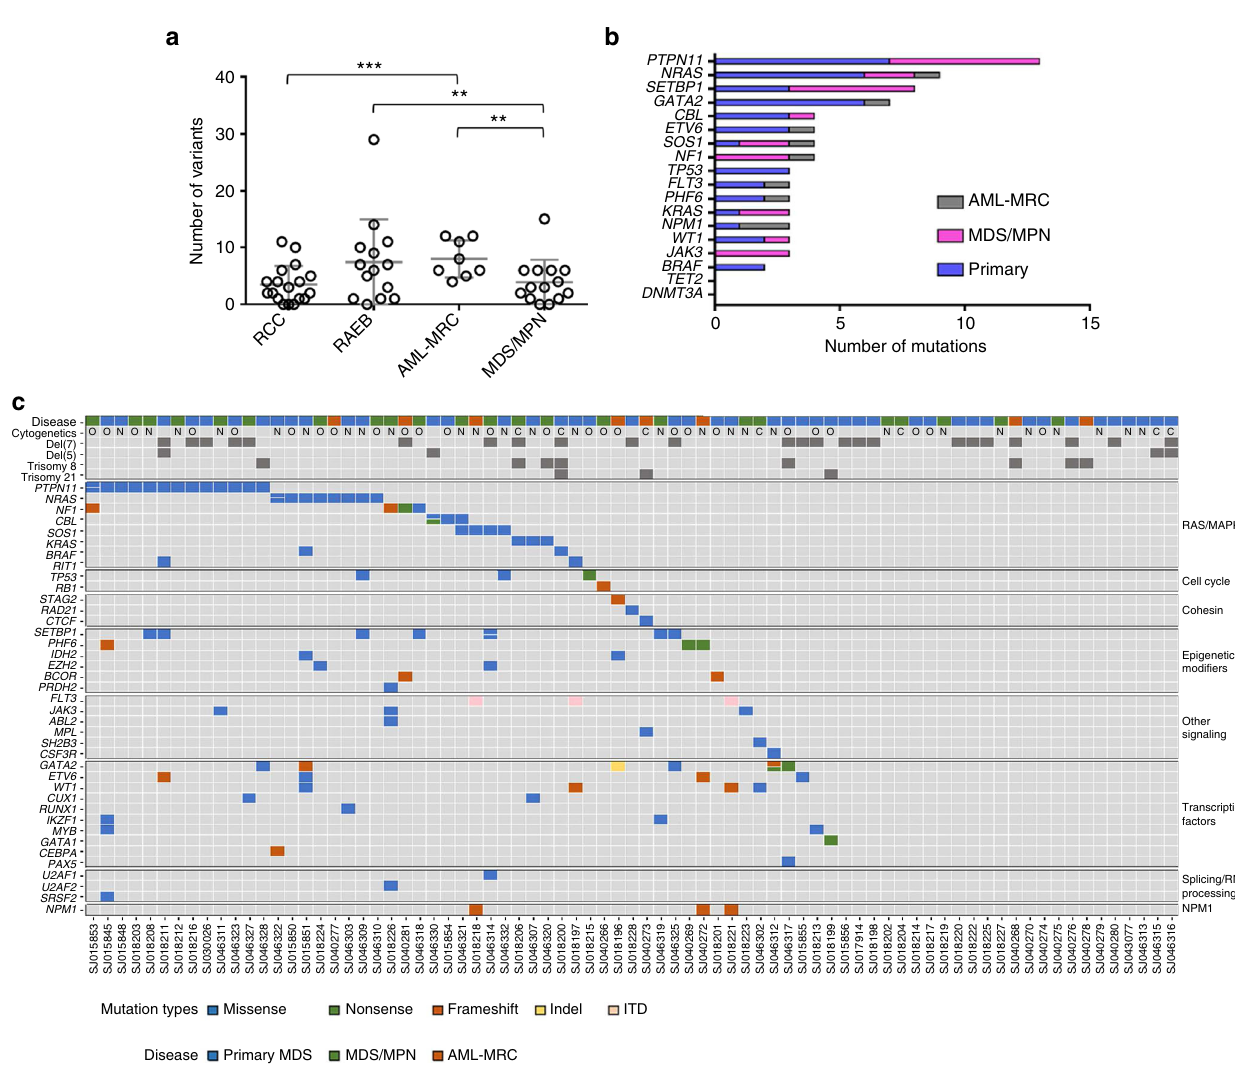
Fig. 2 Somatic mutations in pediatric MDS and related neoplasms. a Total number of somatic variants per patient in the 54 patients with WES data (includes silent, nonsense, missense, frame shifts, indels, ITD, and mutations within 3 ′ and 5 ′ UTR). ** : p = 0.02; *** : p = 0.003 (student ’ s t-test). b The most common genes with somatic mutations in the full cohort of 77 patients (includes WES and targeted amplicon sequencing). Only somatic mutations with presumed functional consequences are shown. c Heat map showing the somatic mutational pro fi le of the pediatric MDS cohort separated by gene functional groups. Only somatic mutations with presumed functional consequences are shown. Split cells indicate multiple mutations. O, other karyotype fi ndings not listed separately; C, complex karyotype; N, normal